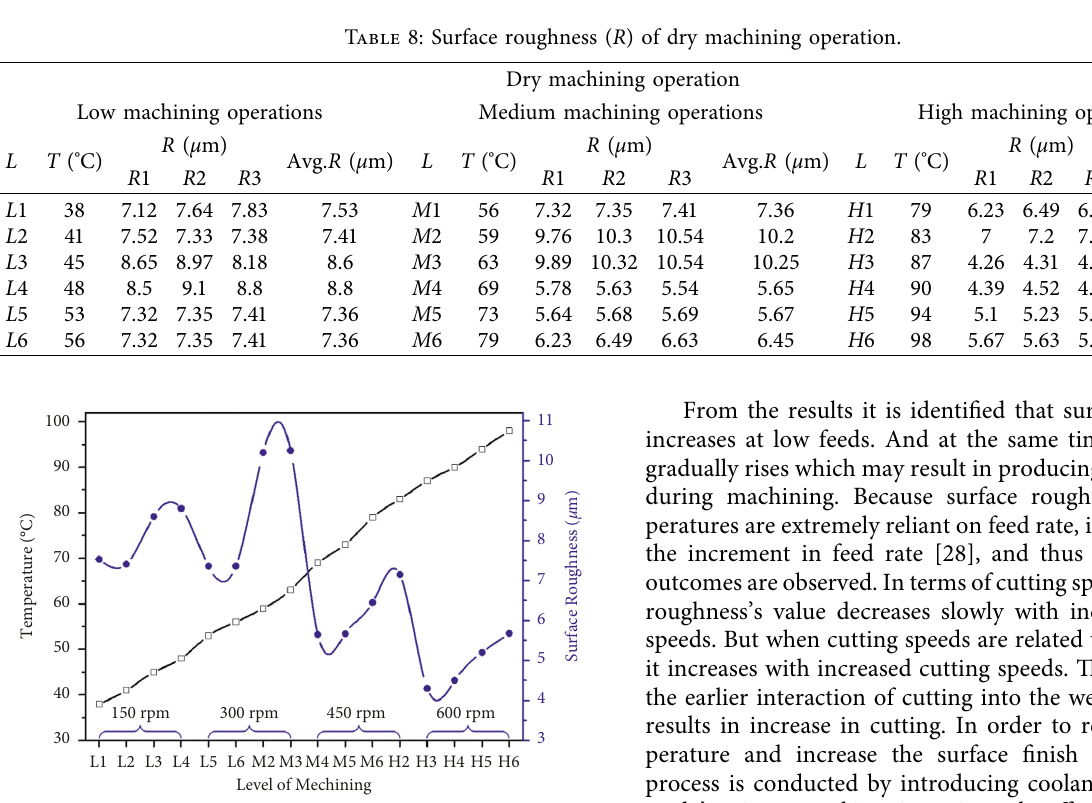
Figure 4: Surface and temperatures at different levels of cutting speed in dry machining.